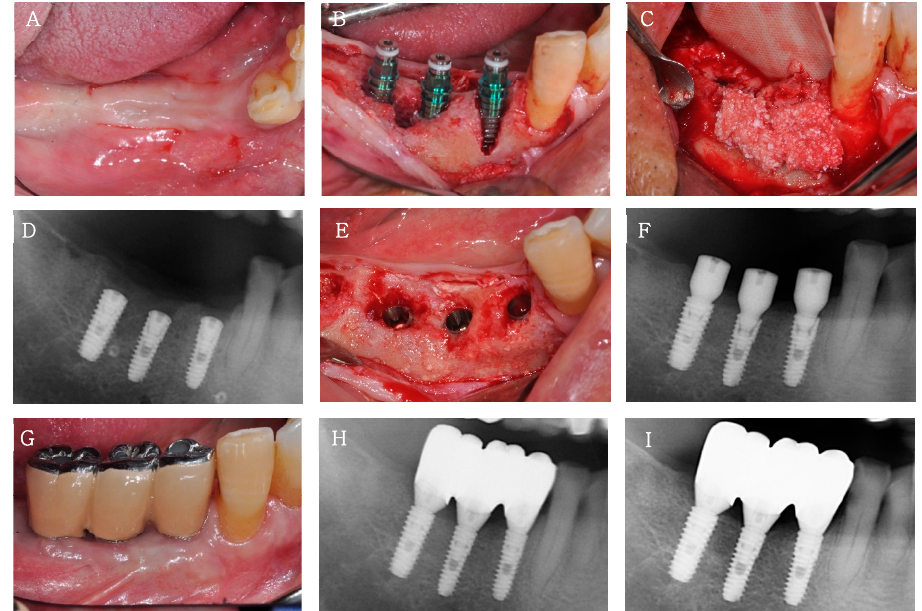
Figure 4. Clinical case 1. ( A ) Clinical view before bone augmentation and implantation of 44, 45, and 46. ( B ) Peri-implant dehiscence defects at 44 and 45. ( C ) Bone augmentation at 44 and 45 using Bontree ® and collagen barrier membrane. ( D ) Radiograph after bone augmentation and implantation. ( E ) Clinical view after flap elevation during the second-stage implant surgery 4 months after implantation. ( F ) Radiograph after the second-stage implant surgery. ( G , H ) Clinical and radiographic views of the final prosthesis 6 months after implantation. ( I ) Radiograph at 1 year after